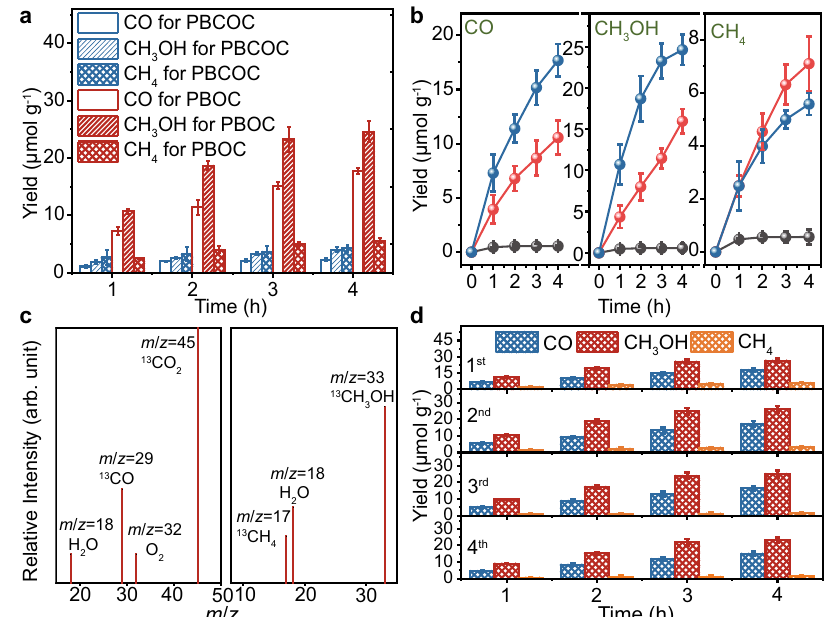
Fig. 4 Photocatalytic CO 2 RR performances of the ultrathin PBOC layers and bulk PBCOC. a Photocatalytic CO 2 RR products under full-spectrum light irradiation. b Photocatalytic CO 2 reduction activities of the ultrathin PBOC in N 2 (grey ball), atmospheric CO 2 (red ball), and pure CO 2 (blue ball) under full-spectrum light irradiation. c GC-MS spectrum of the products with 13 CO 2 . d CO 2 RR cycling measurements under full-spectrum light irradiation for 4 h. Error bars are means ± standard deviation of three